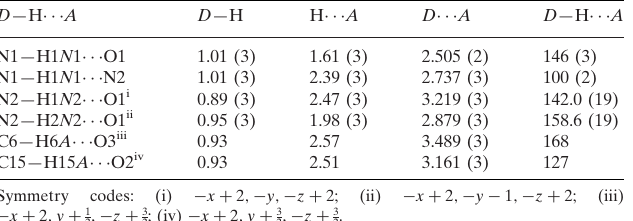
Hydrogen-bond geometry (A˚ , (cid:2) ). D —H (cid:3)(cid:3)(cid:3)